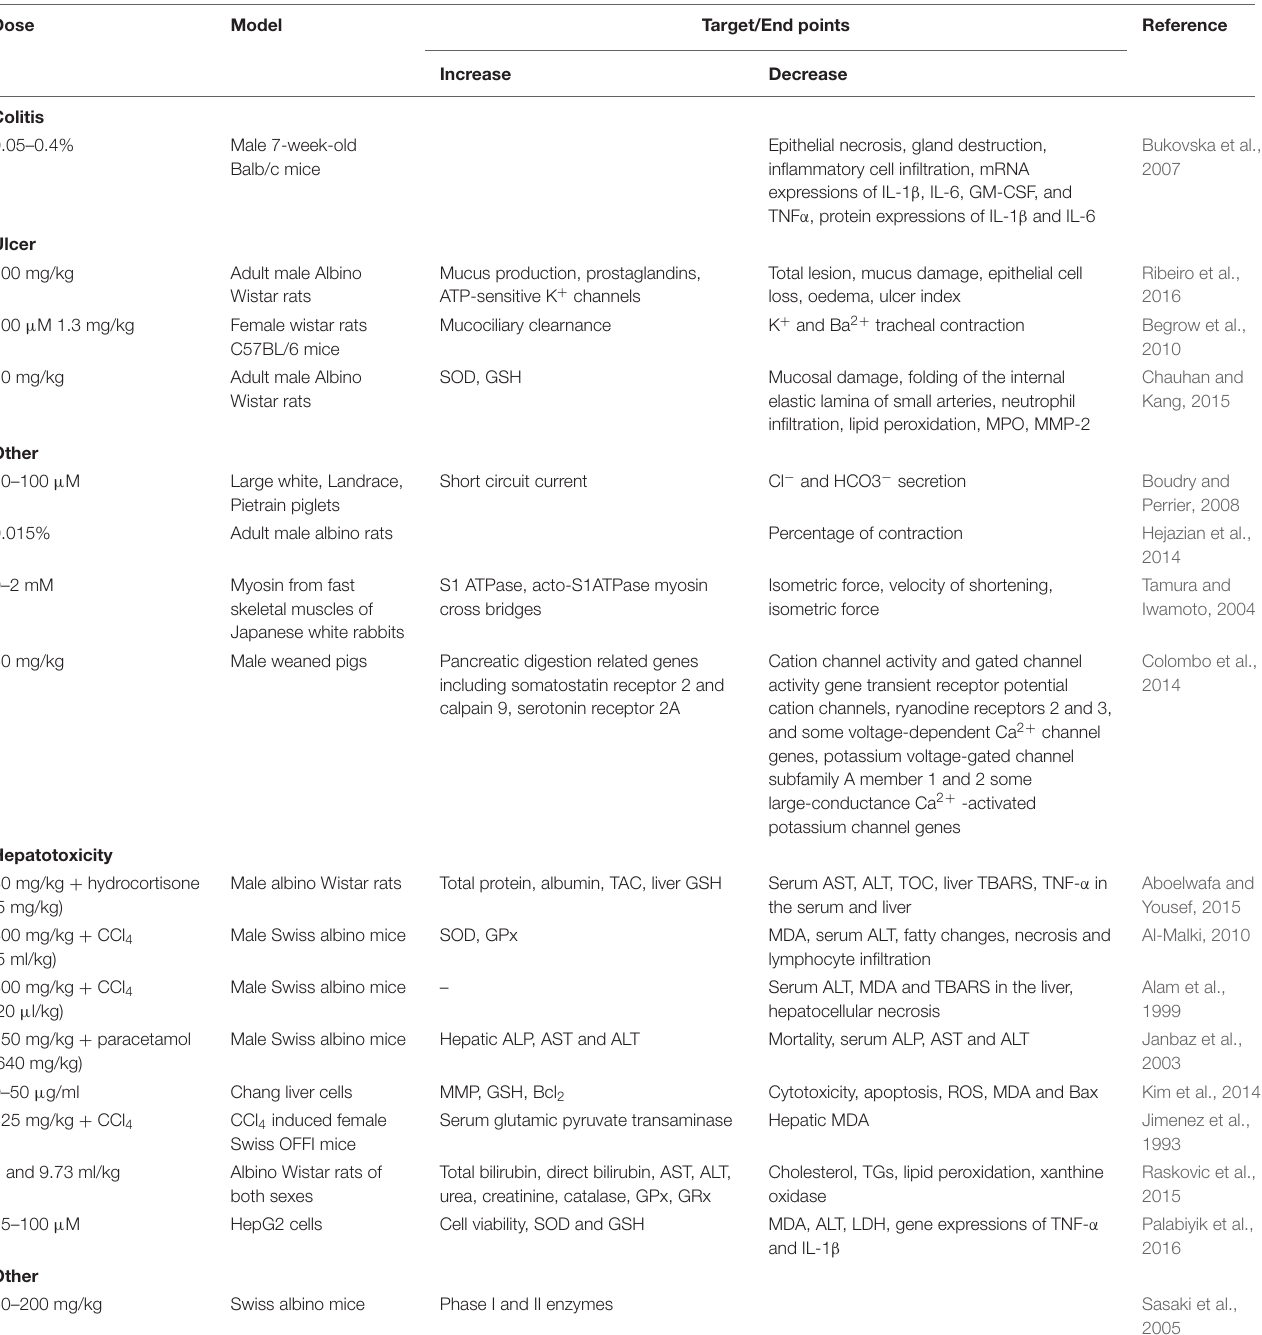
TABLE 4 | Effect of thymol in different experimental models of gastrointestinal